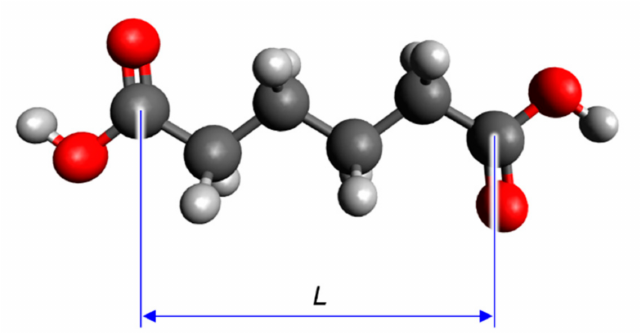
Figure 2. Schematic definition of L in the optimised structure of a carboxylic (in this case, adipic) acid.